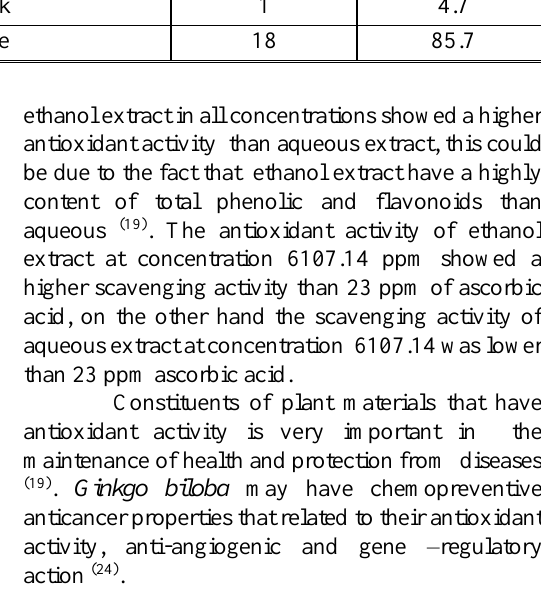
Table 6. The antioxidant activity of Ginkgo biloba aqueous, ethanol and ascorbic acid against DPPH radicals